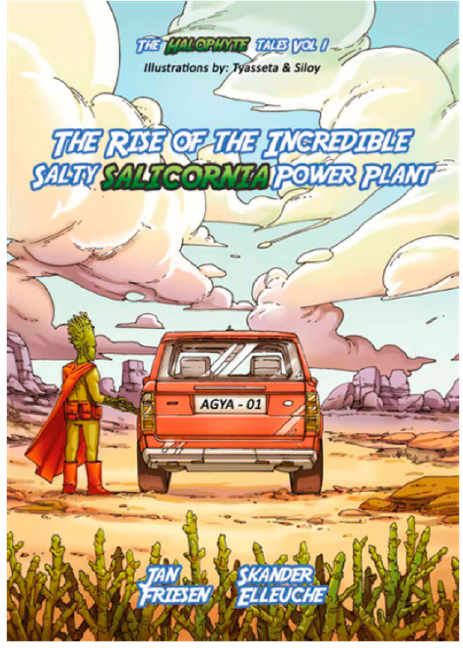
Figure 1. The cover of the first episode of the “Halophyte tales” comic series.